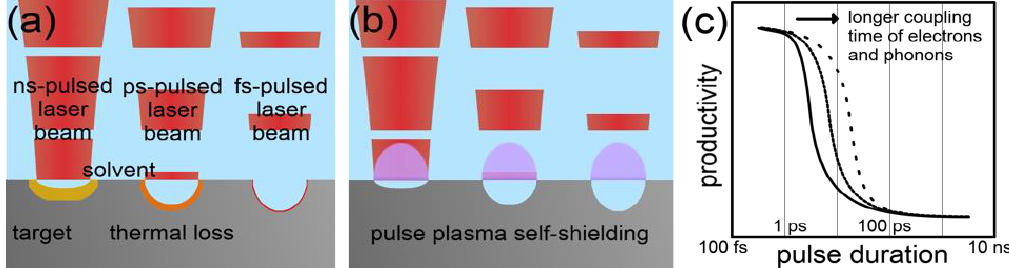
Figure 8. Illustration of the laser ablation of metals in liquids at di ff erent pulse durations neglecting non-linear e ff ects. Thermal losses ( a ) and self-shielding by plasma ( b ) of pulses of di ff erent duration regimes. The diagram in ( c ) demonstrates how the coupling constant of electrons and phonons a ff ects the NP productivity in LAL, depending on the laser pulse duration. A change of the coupling constant was assumed to have no influence on other material properties. In ( c ), the y-axis scales linearly. The trends shown in the diagram represent the interpretation of the combined results of the discussed literature in Section 2.2.1. In ( c ), the arrow and the less dense (dashed) line style indicate the e ff ect of a longer coupling time of electrons and phonons of the target material on productivity. Reprinted with permission from [66].